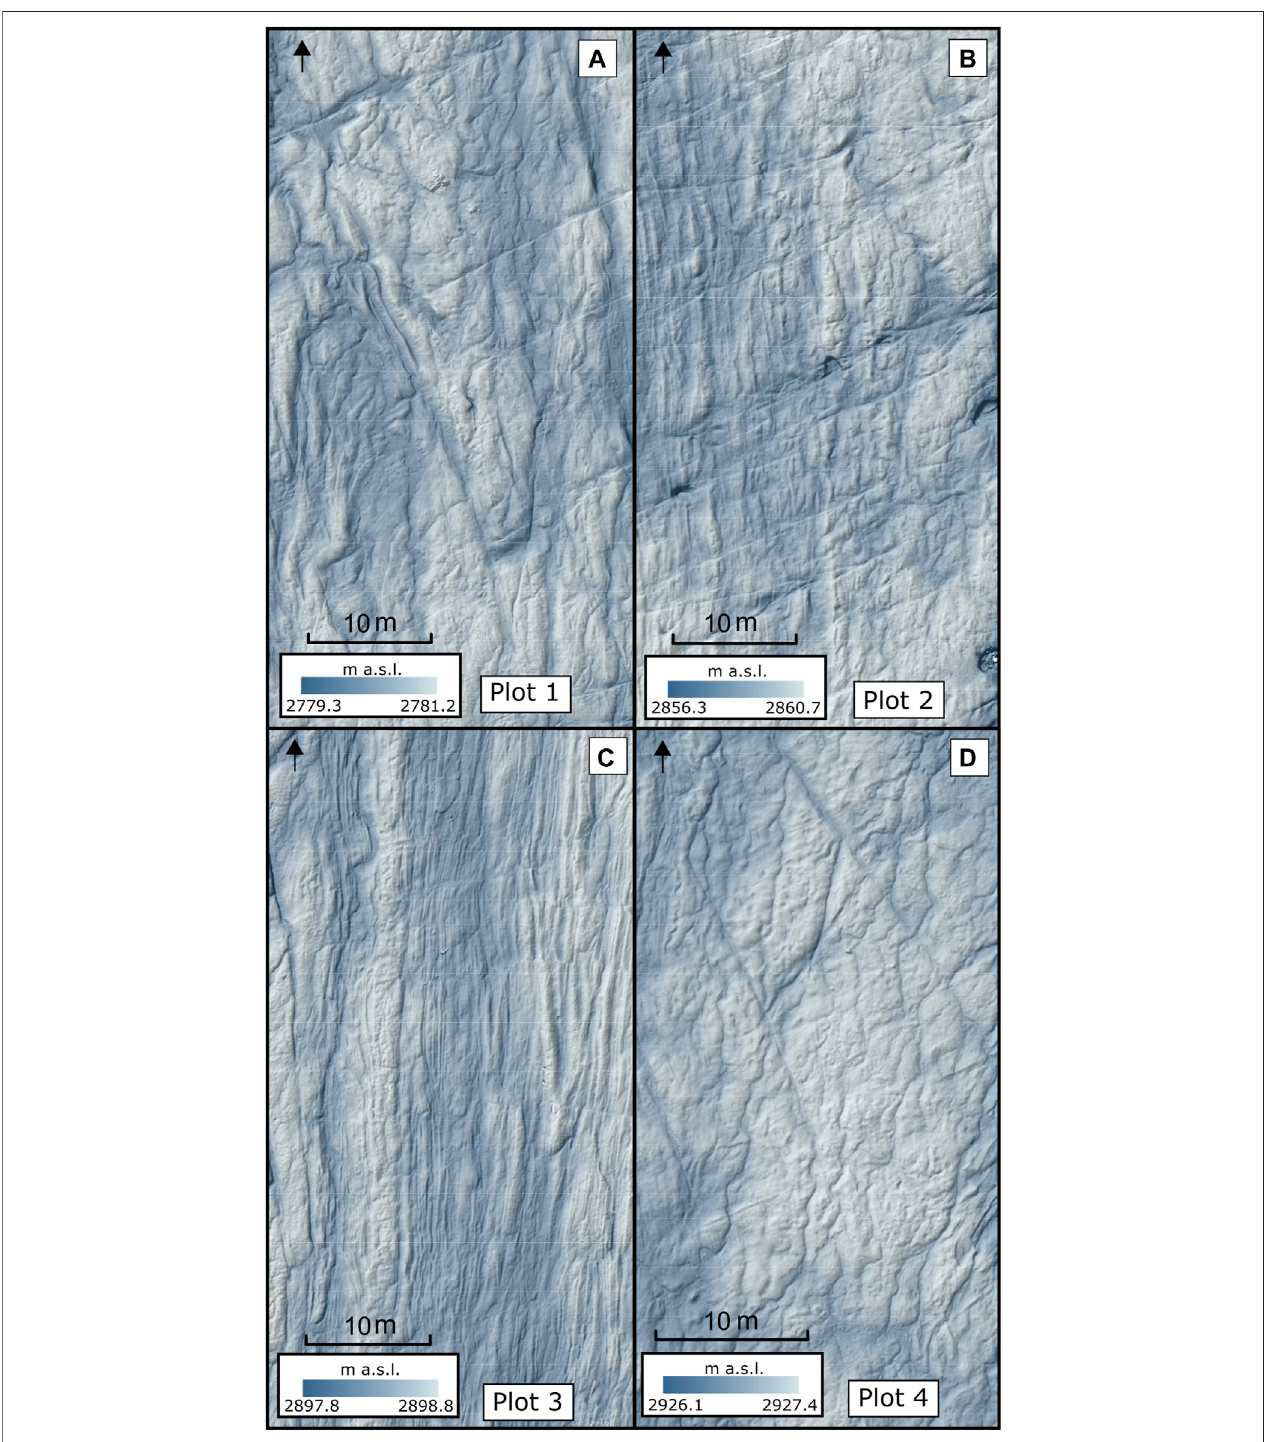
FIGURE 2 | Examples of hillshaded DEMs generated from UAV imagery of each Plot. Black arrows indicate glacier fl ow direction.